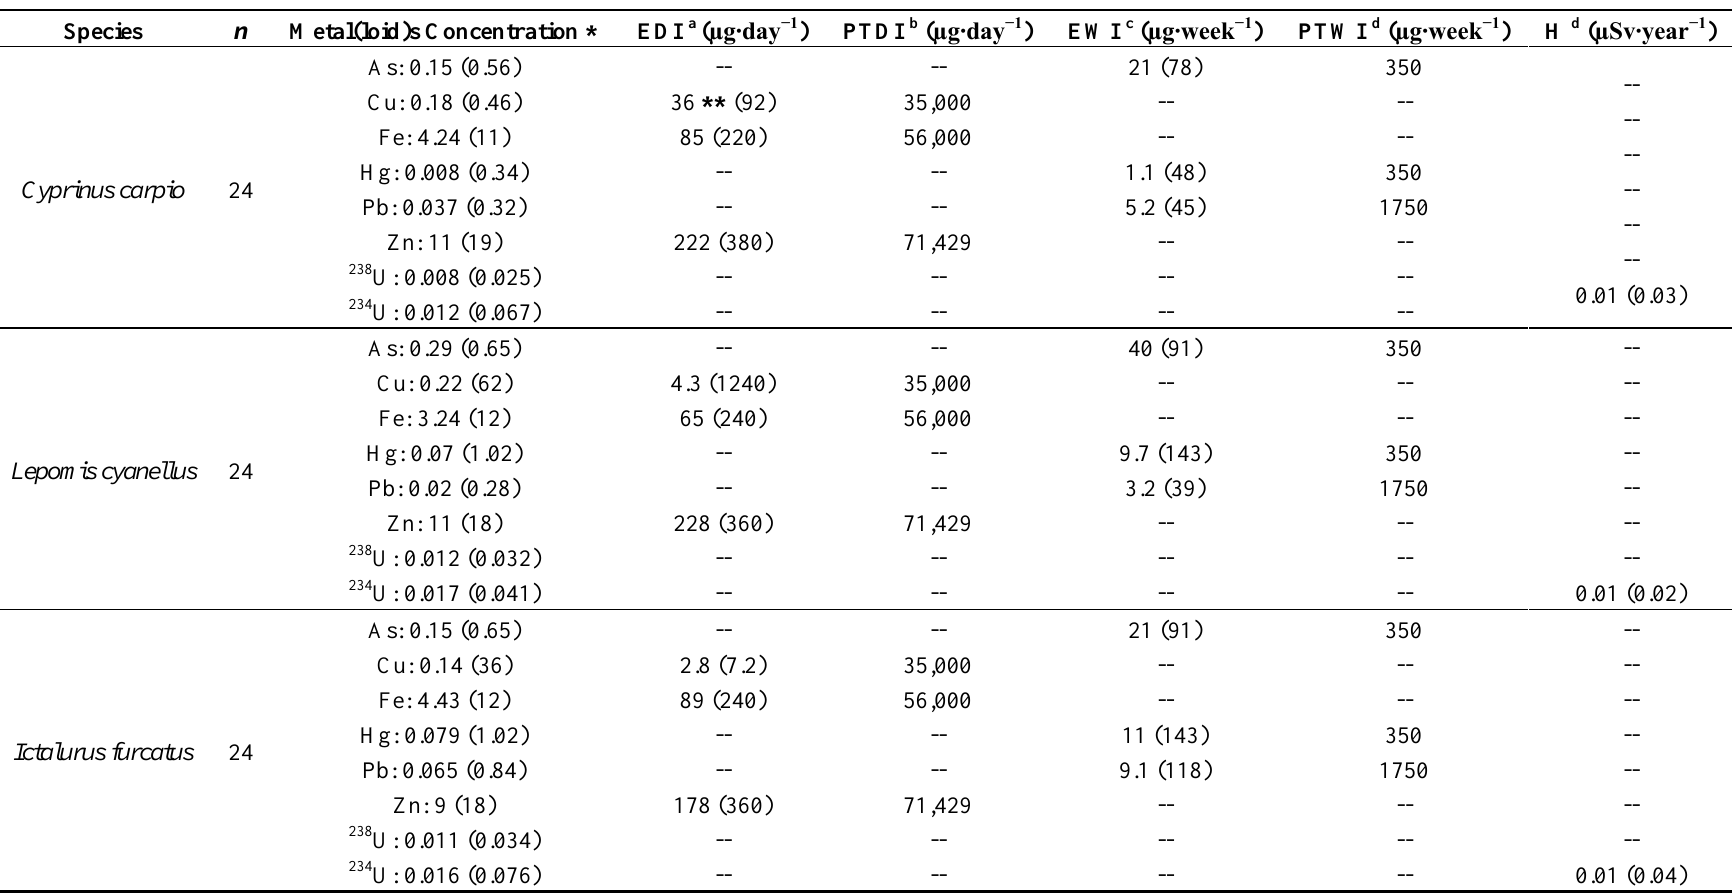
Table 5. Estimated theoretical annual effective dose by uranium ingestion and weekly intakes of metal(loid)s in fish fillet. Species n Metal(loid)s Concentration * EDI a (µg∙day −1 ) PTDI b (µg∙day −1 ) EWI c (µg∙week −1 ) PTWI d (µg∙week −1 ) H d (µSv∙year −1 )